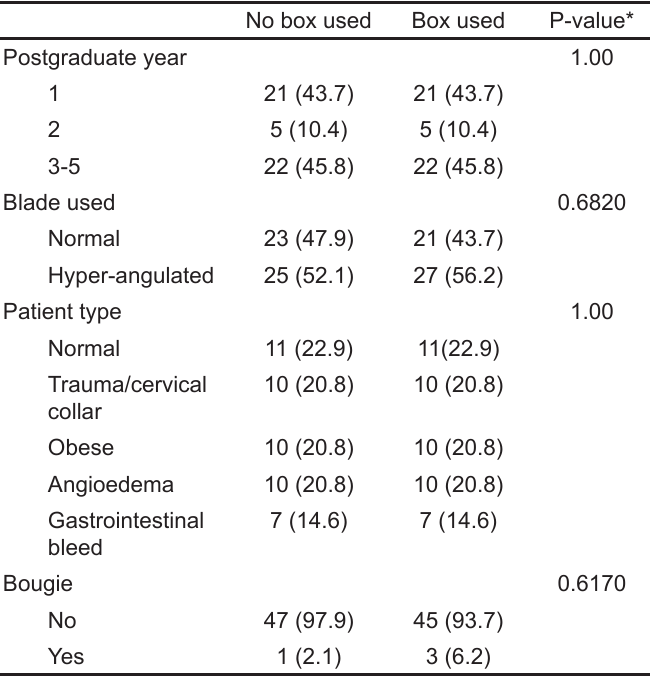
Table 1. Study characteristics (N = 96) of residents and the simulated intubations they performed with and without a transparent aerosol box.